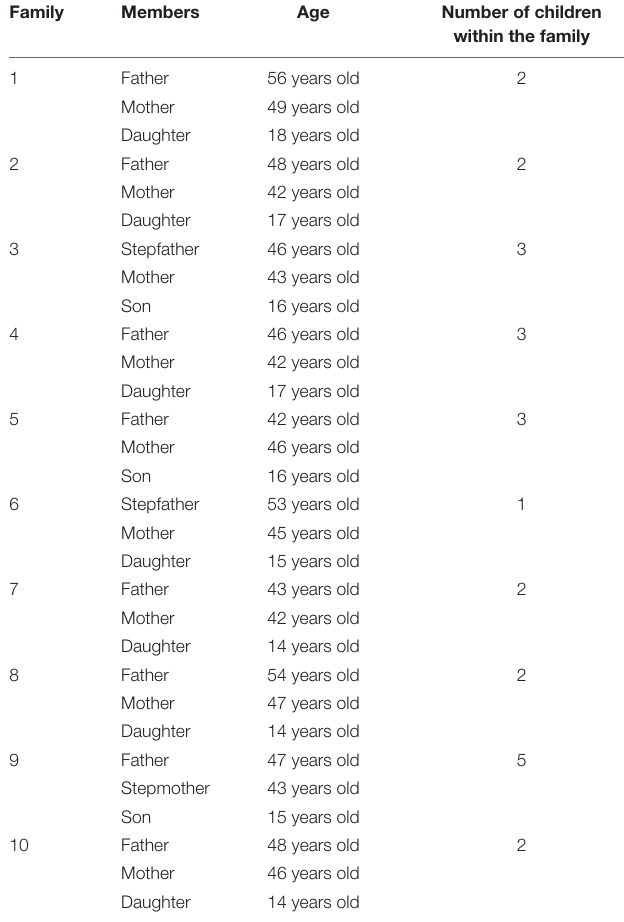
TABLE 1 | Overview of the participants. Family Members Age Number of children